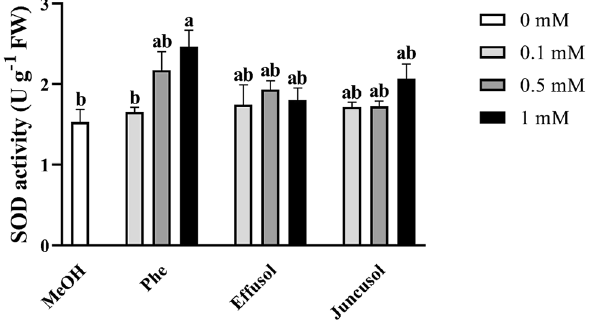
Figure 9. SOD activity of seedlings treated with Phe, effusol and juncusol at different concentrations compared to MeOH. Data are presented as the mean ± SE (n = 3). Different letters indicate significant differences between the values of the treatments (P < 0.05) analysed by Tukey’s post-hoc test.